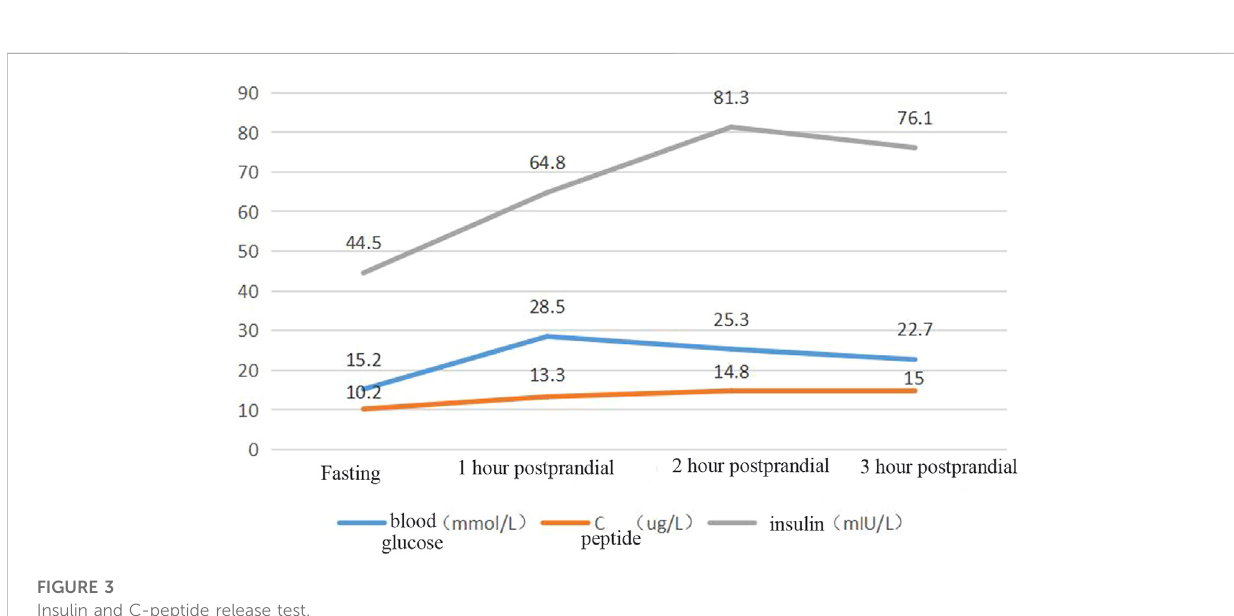
FIGURE 3 Insulin and C-peptide release